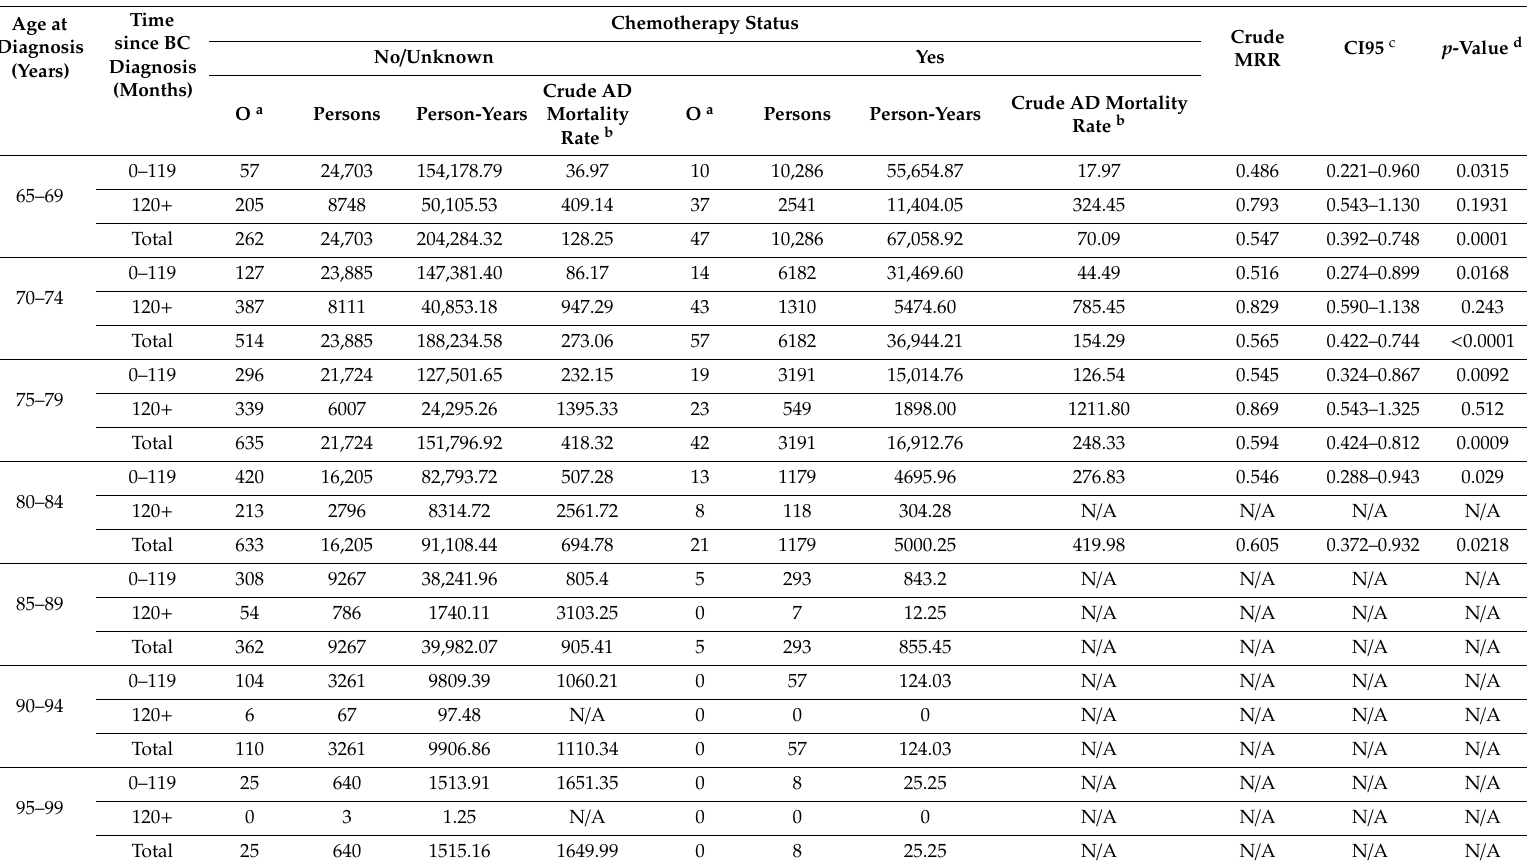
Table 3. Crude Alzheimer’s disease mortality rates and mortality rate ratios (MRR) for breast cancer patients from SEER (Surveillance, Epidemiology, and End Results) 13 for di ff erent chemotherapy statuses. Mortality rates and MRRs were not calculated for subgroups with O <